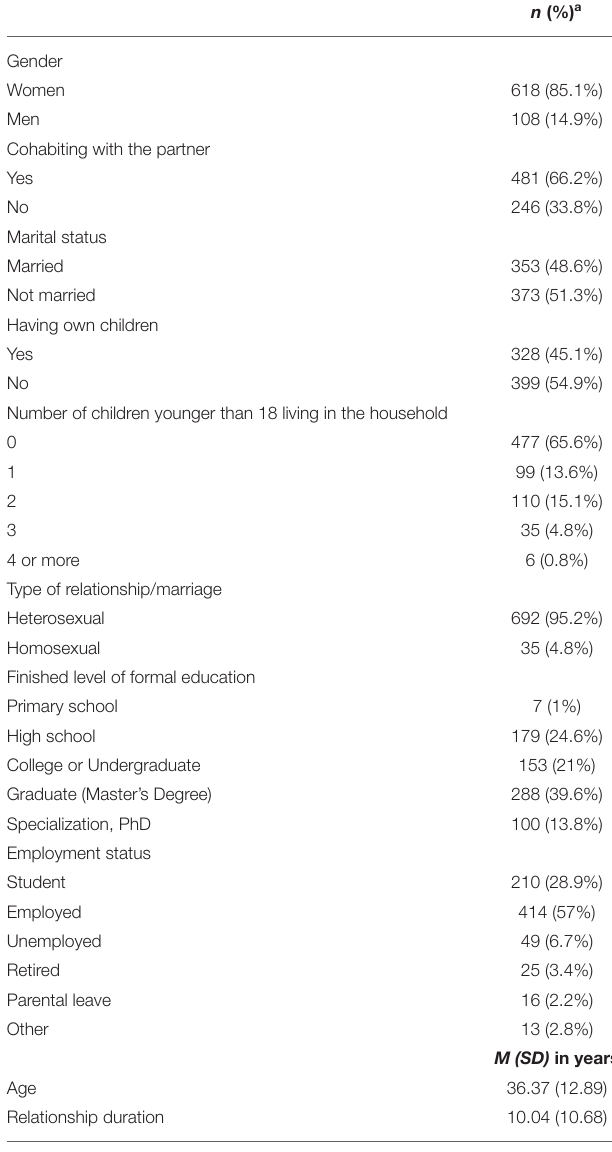
TABLE 1 | Sociodemographic characteristics of the